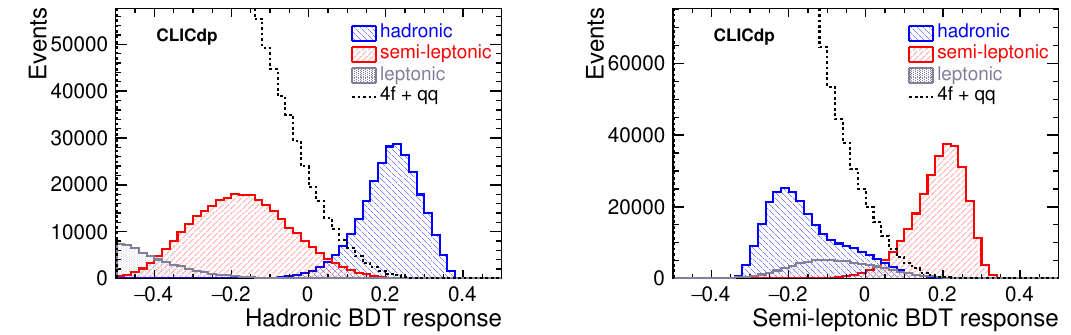
Figure 14. Response distributions for BDT classi(cid:12)ers trained to recognise hadronic top-quark pair events (left) and semi-leptonic top-quark pair events (right). Distributions for di(cid:11)erent samples of tt events and other SM backgrounds are compared for 1 : 0 ab (cid:0) 1 at 380 GeV